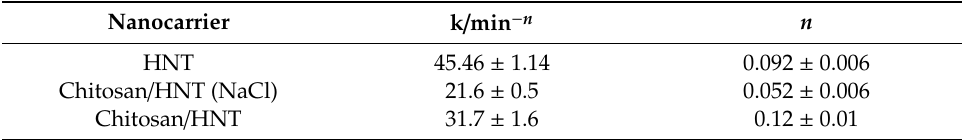
Figure 4. Khellin release as a function of time in water under neutral conditions (pH = 7). Solid lines represent the fitting according to the Korsmeyer–Peppas model (Equation (5)). Table 4. Fitting Parameters for khellin release at pH = 7.